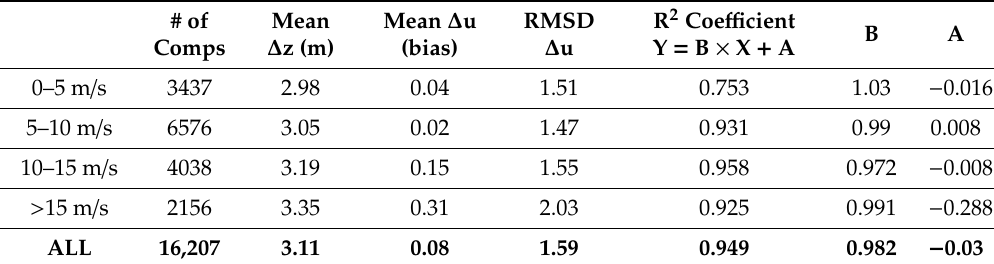
Table 10. DAWN-dropsonde comparison statistics by DAWN wind speed for v component of the horizontal